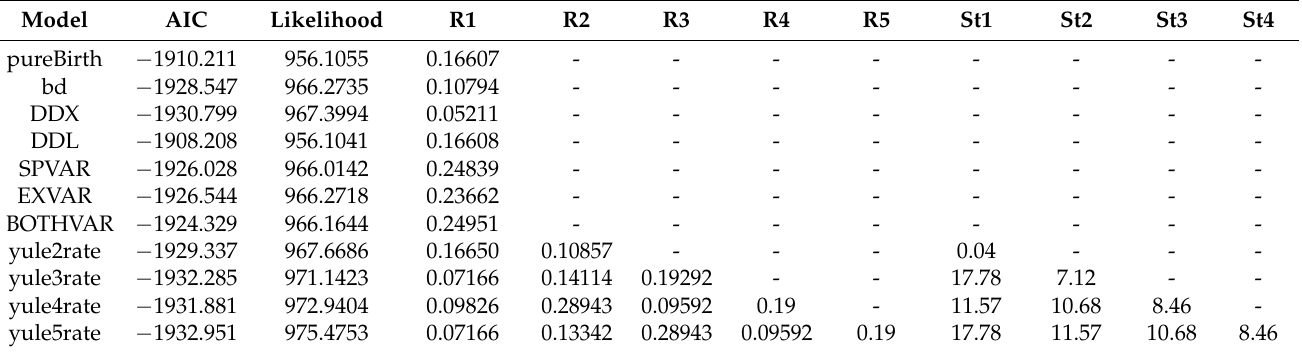
Table 1. Results of diversification rate model-fitting test with parameters estimated under each model. “R” indicates the speciation rate, “St” indicates where the speciation rate